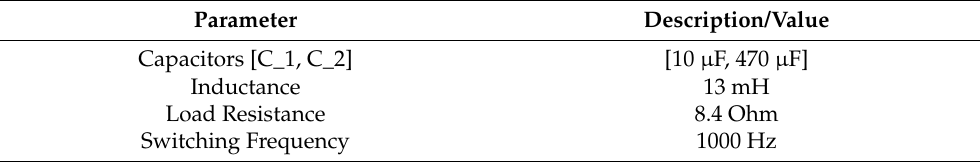
Table 1. Boost converter specifications.